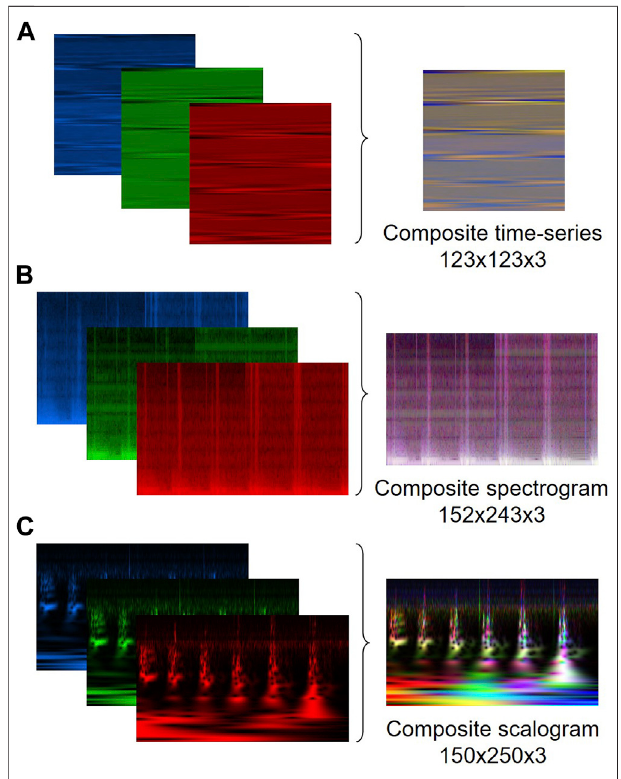
FIGURE 4 | Sample composite input and corresponding lateral load, displacement, and axial load components for the (A) time-series (B) spectrogram, and (C) scalogram